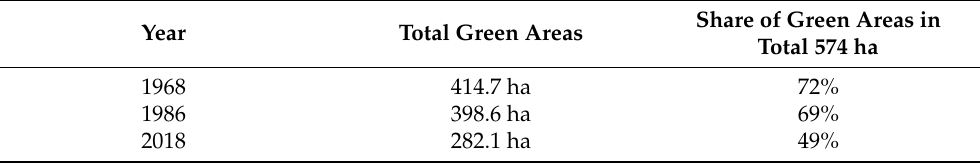
Table 5. The share of green areas along the Trnava-Vuger streams. Source: